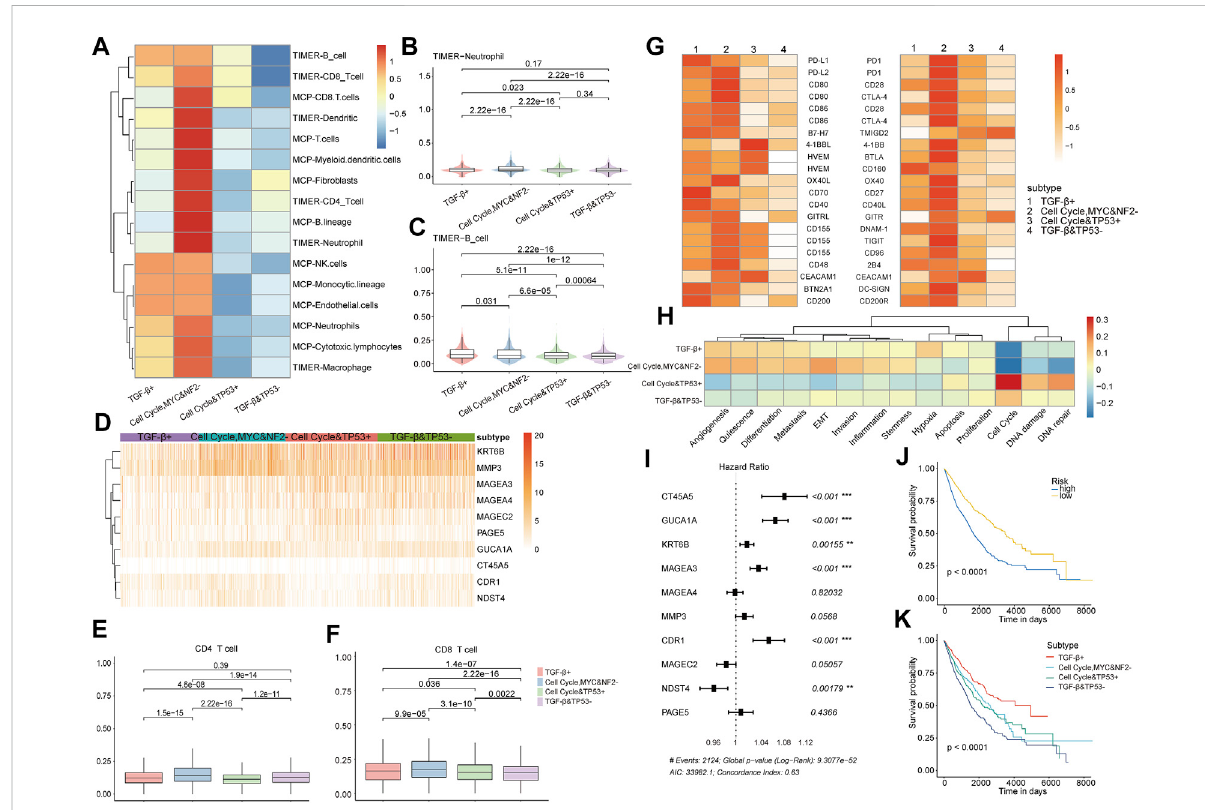
FIGURE 7 (A) Normalized in fi ltration of immune cells from TIMER and MCP in the four subtypes. (B , C) Violin chart of TIMER neutrophils and B-cell in fi ltration. (D) Geneexpressionheatmapofsubtype-speci fi cT-celldysfunctiongenes. (E , F) BoxplotofTIMERCD4T-cellandCD8T-cellin fi ltration. (G) Immune checkpointtumorcells(left)andimmunecheckpointTcells ’ (right)correspondinggenenormalizedexpressioninthefoursubtypes. (H) Cellstateenrichmentscores ’ heatmap. (I) HRvalues of10subtype-speci fi cT-celldysfunction genes. (J , K) KMsurvivalcurves oftheprognostic classi fi er (left) and subtype classi fi er (right) constructed with 10 subtype-speci fi c T-cell dysfunction genes as